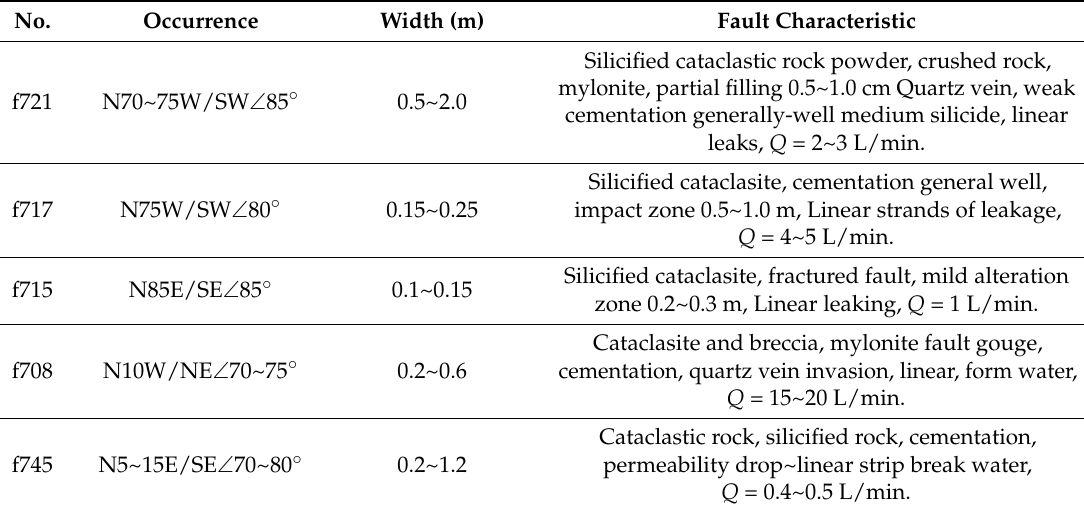
Figure 4. Layout of the geological map in the Yangjiang pumped-storage power station. Table 3. Key faults information selected in the study area.